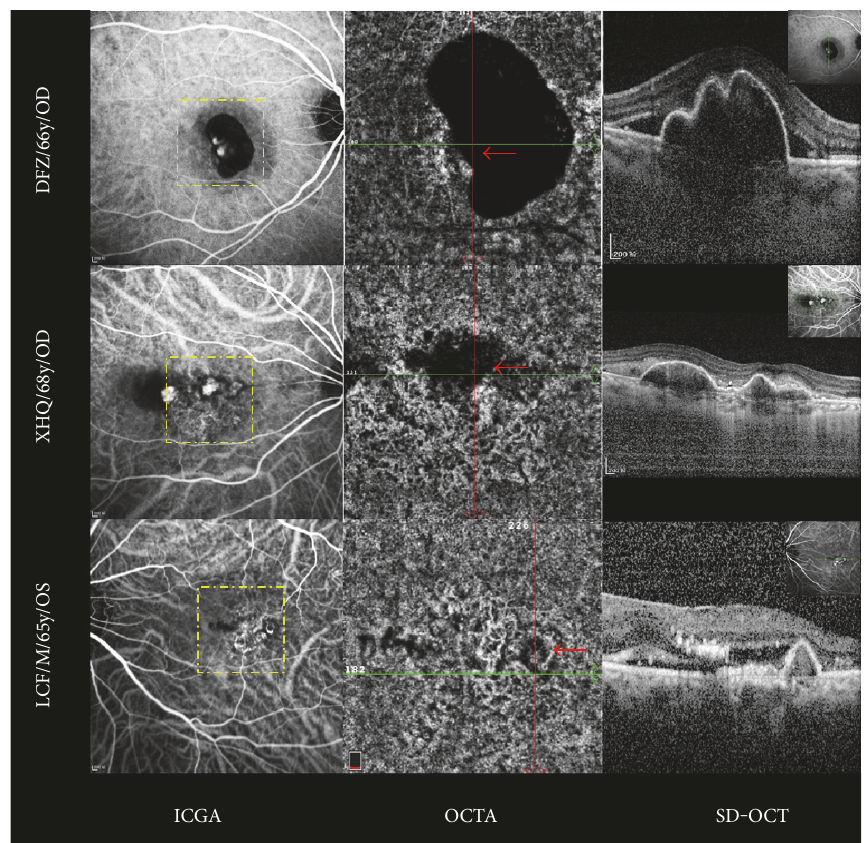
Figure 5: Polypoidal choroidal vasculopathy on OCTA. The round hypo fl ow appearance of the polyps on OCTA is probably due to unusual blood fl ow inside the polypoidal lesion (red arrows) in contrast with that in the branching vascular network. This indicates that blood fl ow is not within the detection limit of the OCTA device (yellow dash-dots on indocyanine green angiography show the range of OCTA; SD- OCT shows both RPE detachment and a double-layer sign; the left side shows anonymised patient information). ICGA: indocyanine green angiography; OCTA: optical coherence tomography angiography; RPE: retinal pigment epithelium; SD-OCT: spectral-domain optical coherence